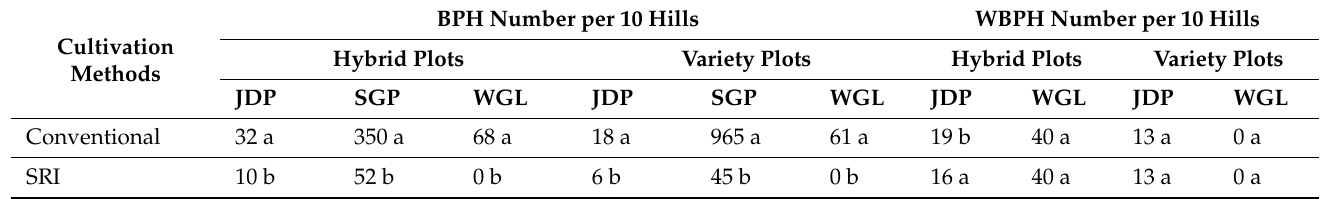
Table 1. Planthopper (BPH and WBPH) incidence with different methods of rice cultivation.